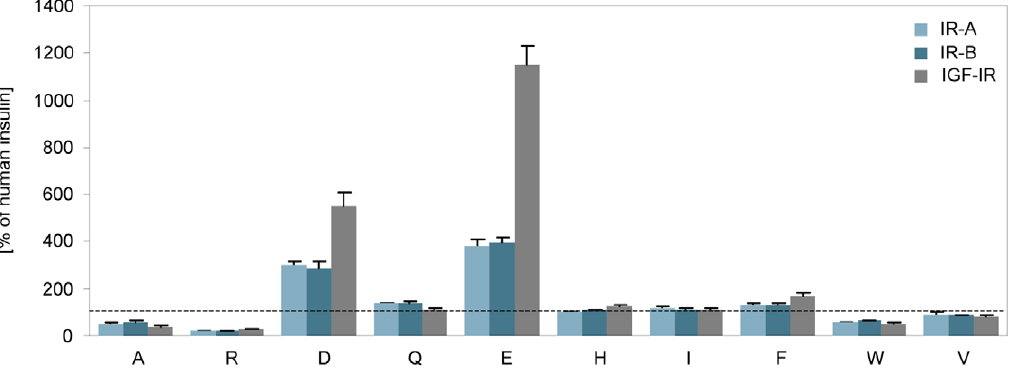
Figure 1. Relative receptor binding affinities. Receptor binding affinities for the solubilised IR-A (light teal), IR-B (dark teal) and IGF-IR (gray) relative to human insulin. The gray dotted line represents 100% binding affinity compared to that of human insulin. Data are means 6 SD (n=3).